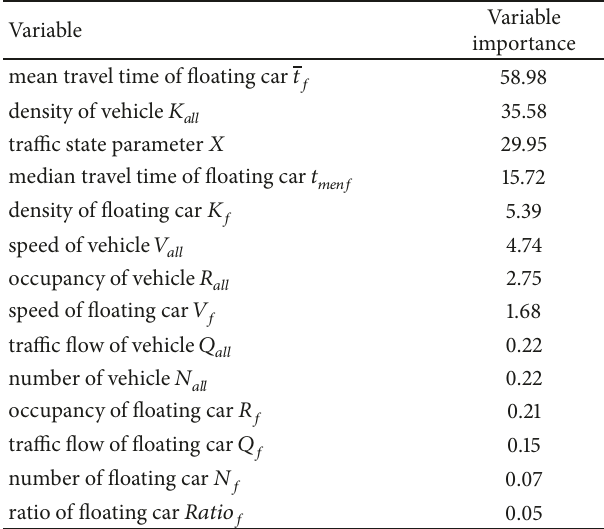
Table 6: Variable